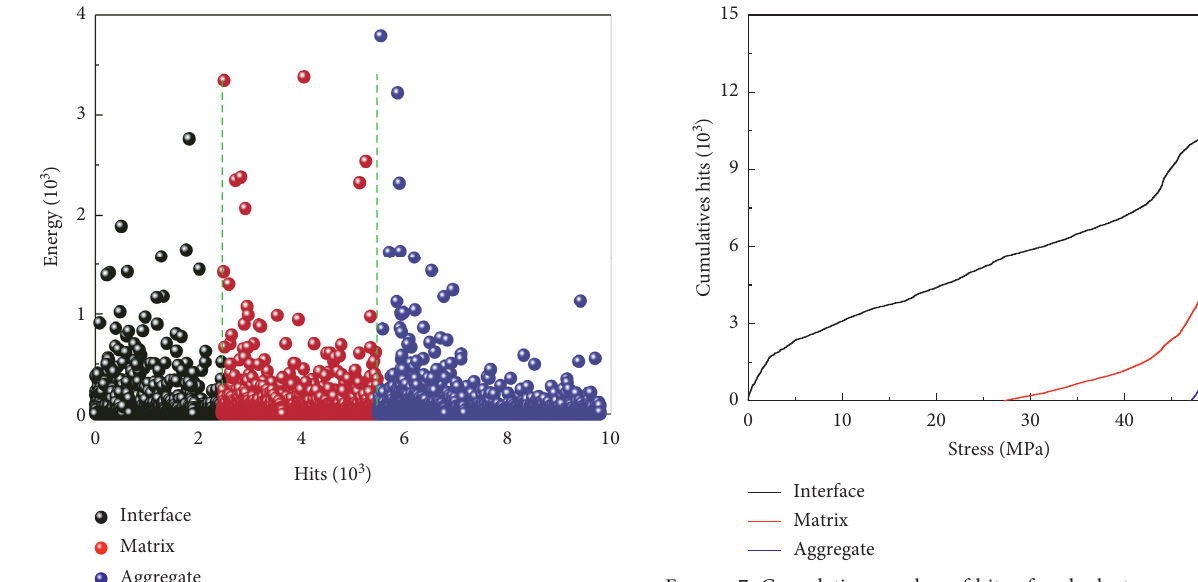
Figure 7: Cumulative number of hits of each cluster versus stress.